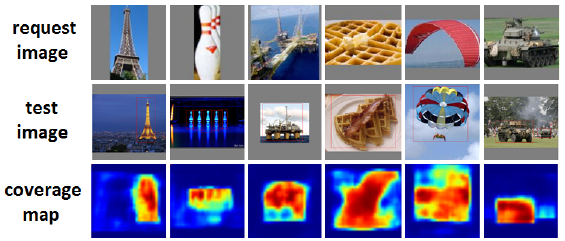
Figure 8. Qualitative Examples for the unseen classes detection: request image, test image and coverage map (Redmon et al., 2016) CNN architectures. We train our net on the ImageNET-200 dataset (200 seen classes, 90% images for learning, 10% - for testing) and test both on the testing part of ImageNET-200 dataset and on ImageNET-90 dataset (90 unseen classes). We propose the detection-by-request training and test- ing protocols on ILSVRC 2014 for semantic matching